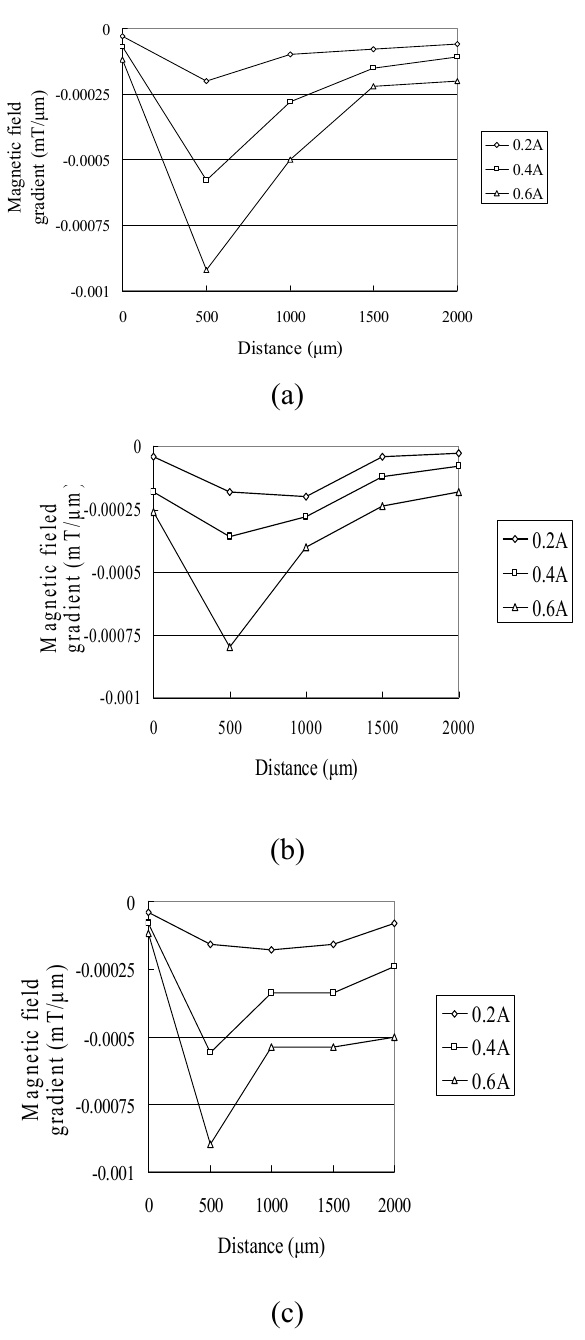
Figure 5. Variations of magnetic field gradient with distance as function of input current for micro-coils with different widths: (a) 125 μ m, (b) 100 μ m and (c) 75 μ